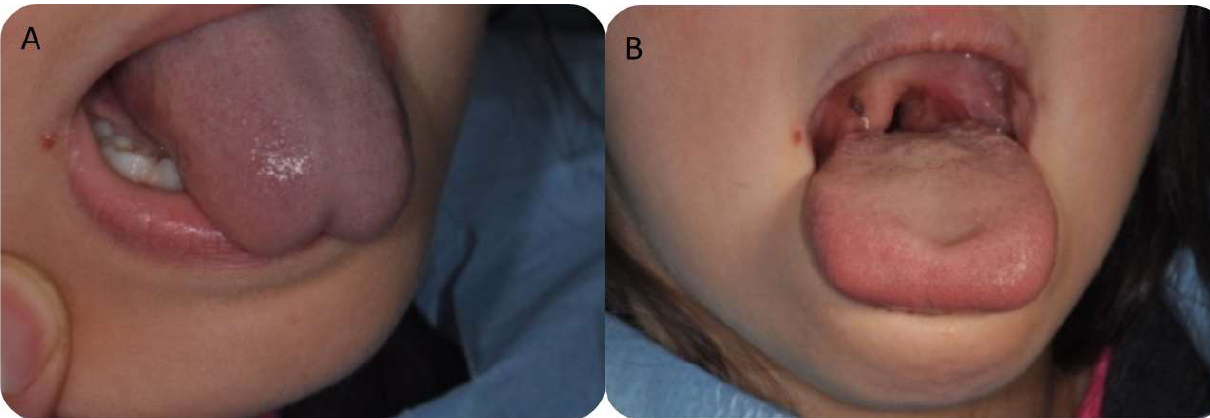
Figure 2. ( A ) During plasma jet. ( B ) Clinical aspect after frenectomy with atmospheric plasma jet; no bleeding was observed.